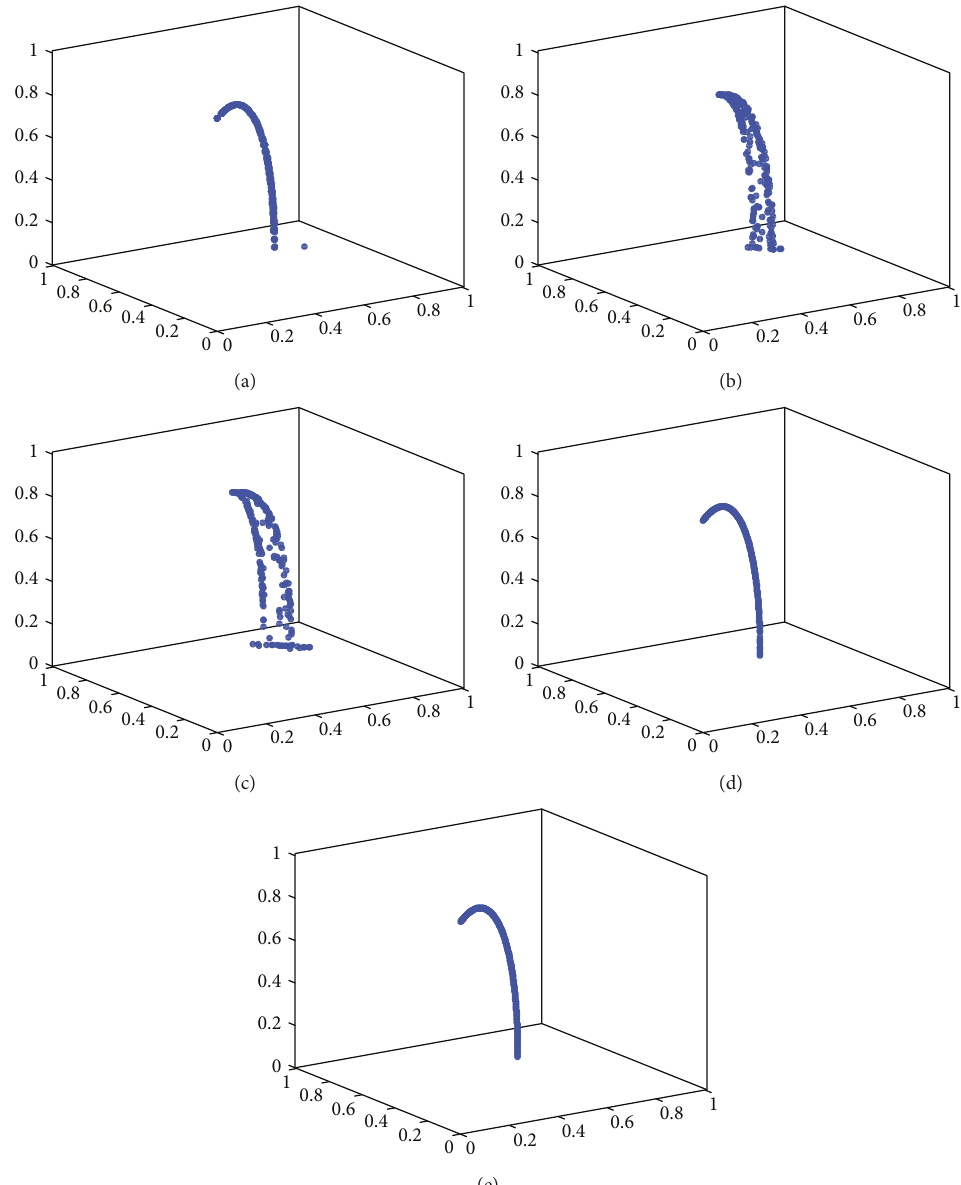
Figure 9: The typical Pareto front obtained by 5 algorithms on DTLZ6. (a) MOEA/D, (b) NSGA-II, (c) NNIA, (d) MODE, and (e)